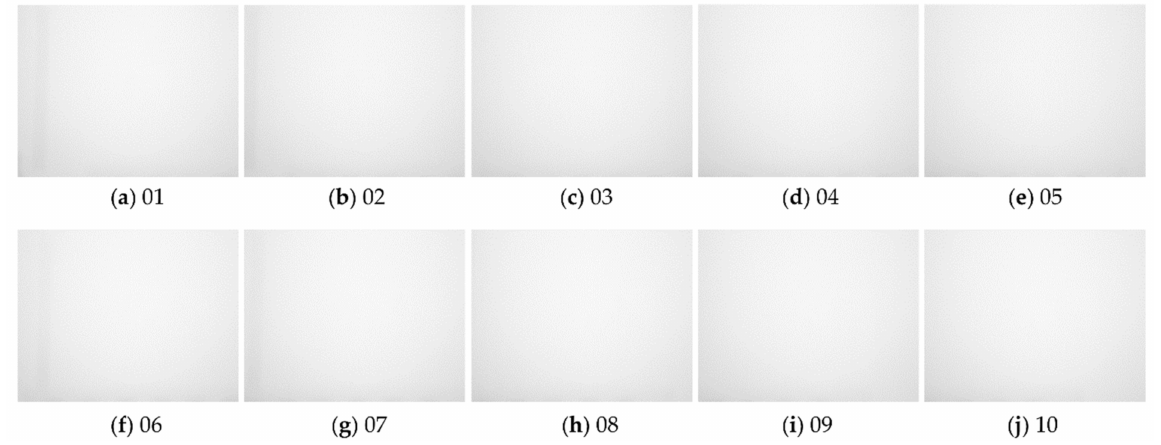
Figure 6. Invisible images of the distant target from 10 viewpoints, corresponding to Figure